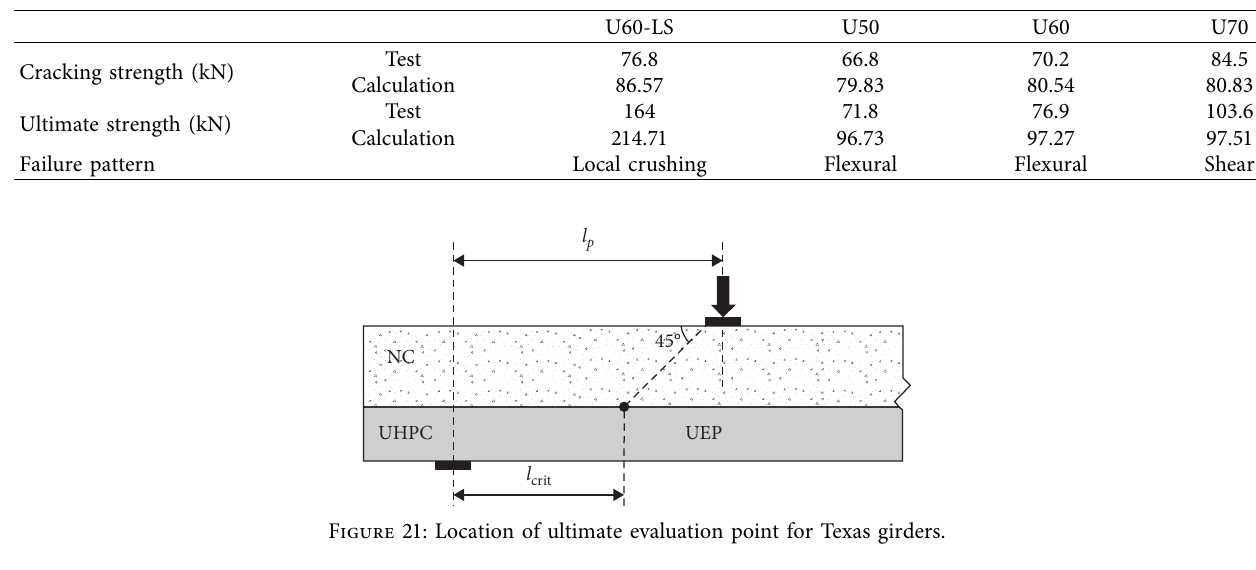
Table 5: Predicted results for tested composite beams.